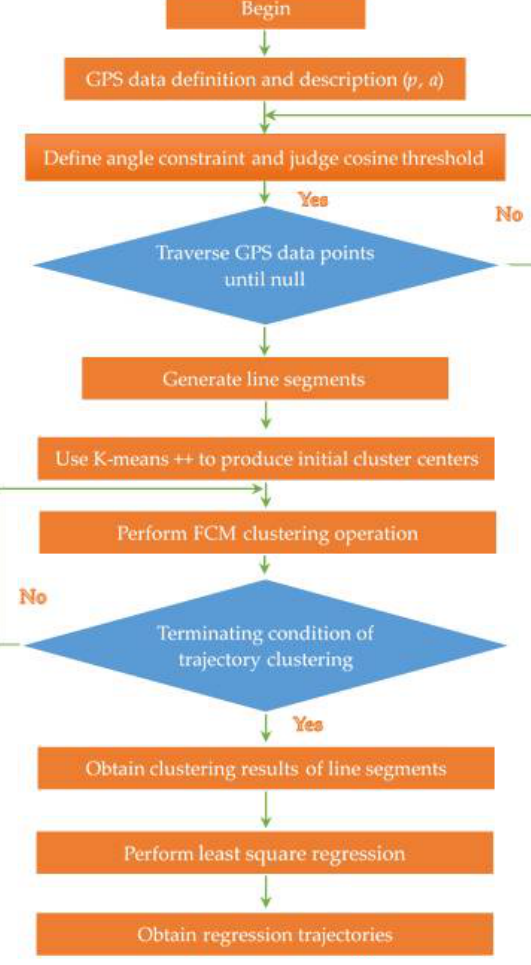
Figure 6. The overall flowchart of our methodology.